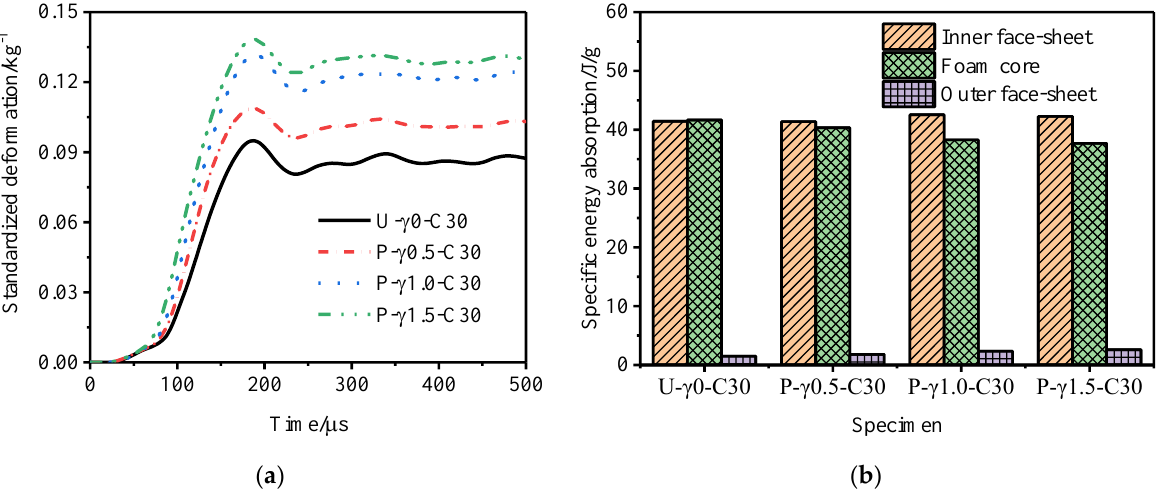
Figure 14. Anti − explosion performance of a P-type aluminum foam sandwich tube. ( a ) Deformation curve of the outer tube, and ( b ) specific energy absorption of sandwich tube.